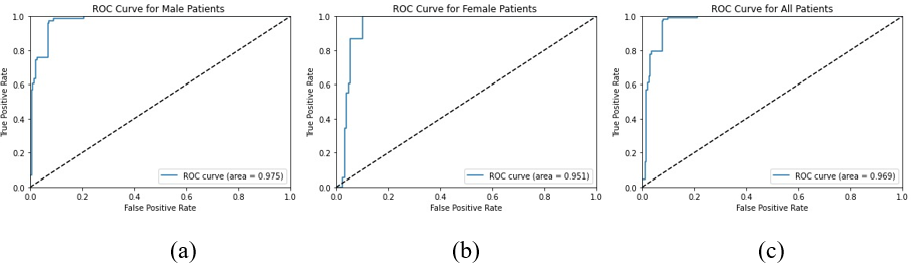
Figure 6. ROC curve of the Diabetic Retinopathy model for ( a ) males, ( b ) females, and ( c ) all of the patients.